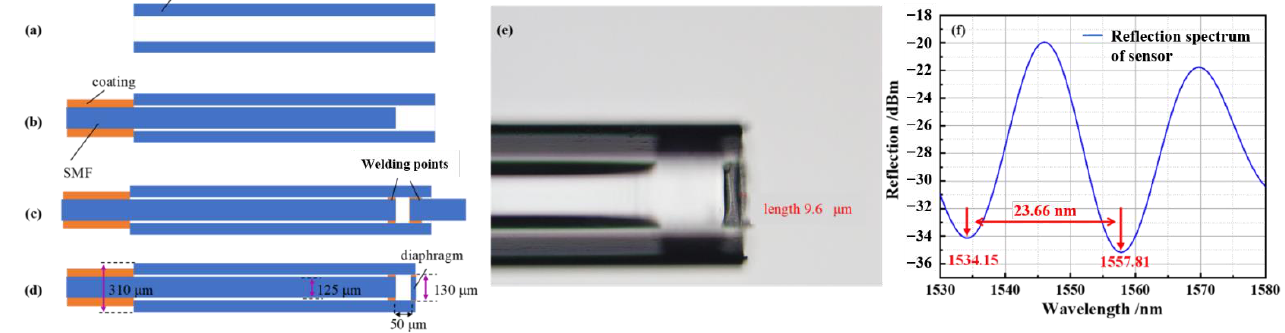
Figure 4. Fabrication of the diaphragm-based FP pressure sensor. ( a – d ) Steps of sensor fabrication; ( e ) the sensor’s graph under a microscope; ( f ) the reflection spectrum of the pressure sensor.